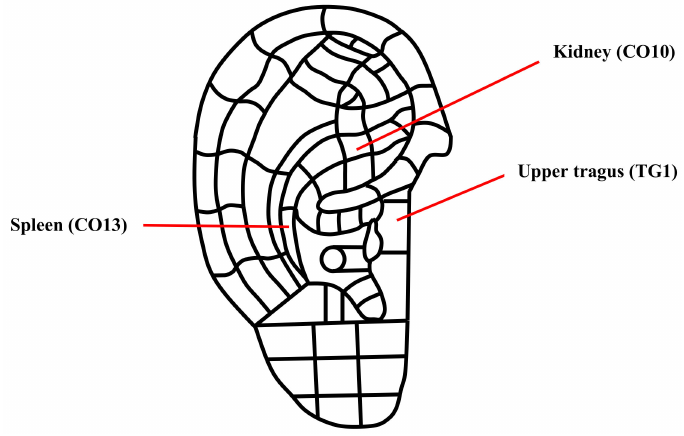
Figure 2. A map of the three auricular acupoints used in this